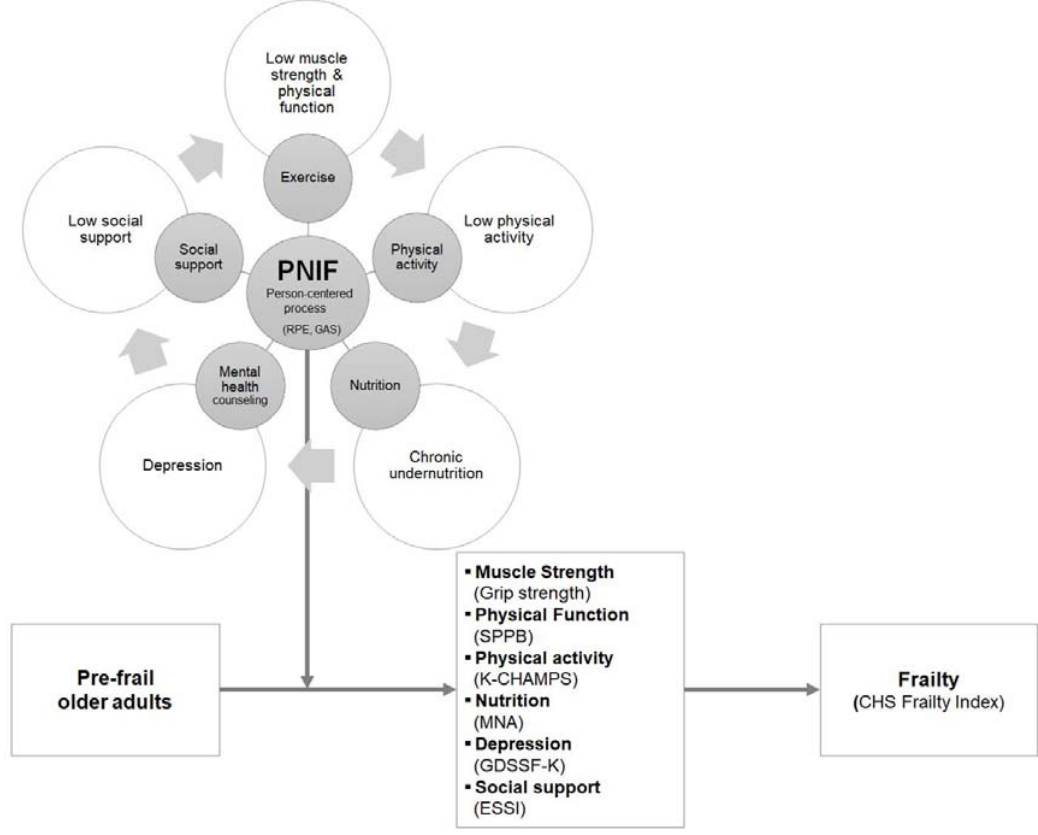
Figure 2. Conceptual framework of this study.